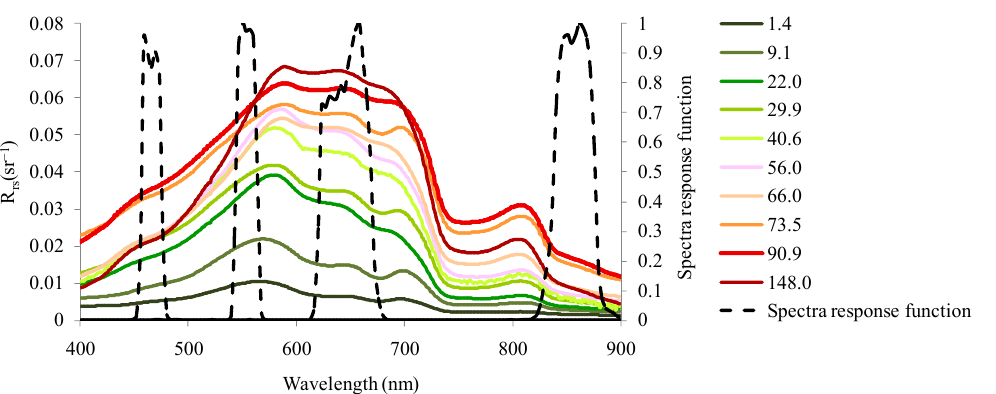
Figure 2. Remote sensing reflectance (R rs ) values (dashed lines) for various ρ TSS (mg/L) levels and relative spectral response functions of the MODIS (broken lines).